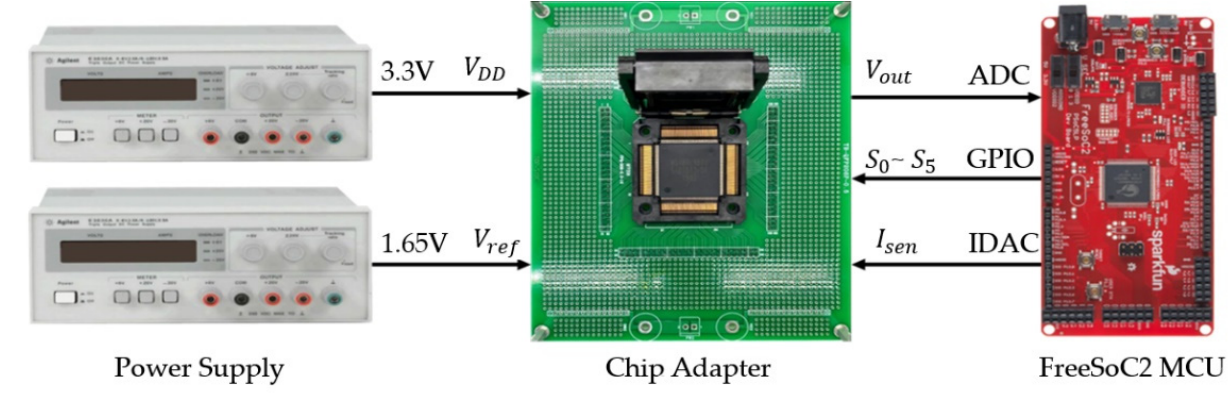
Figure 11. Block diagram of the experimental test setup.